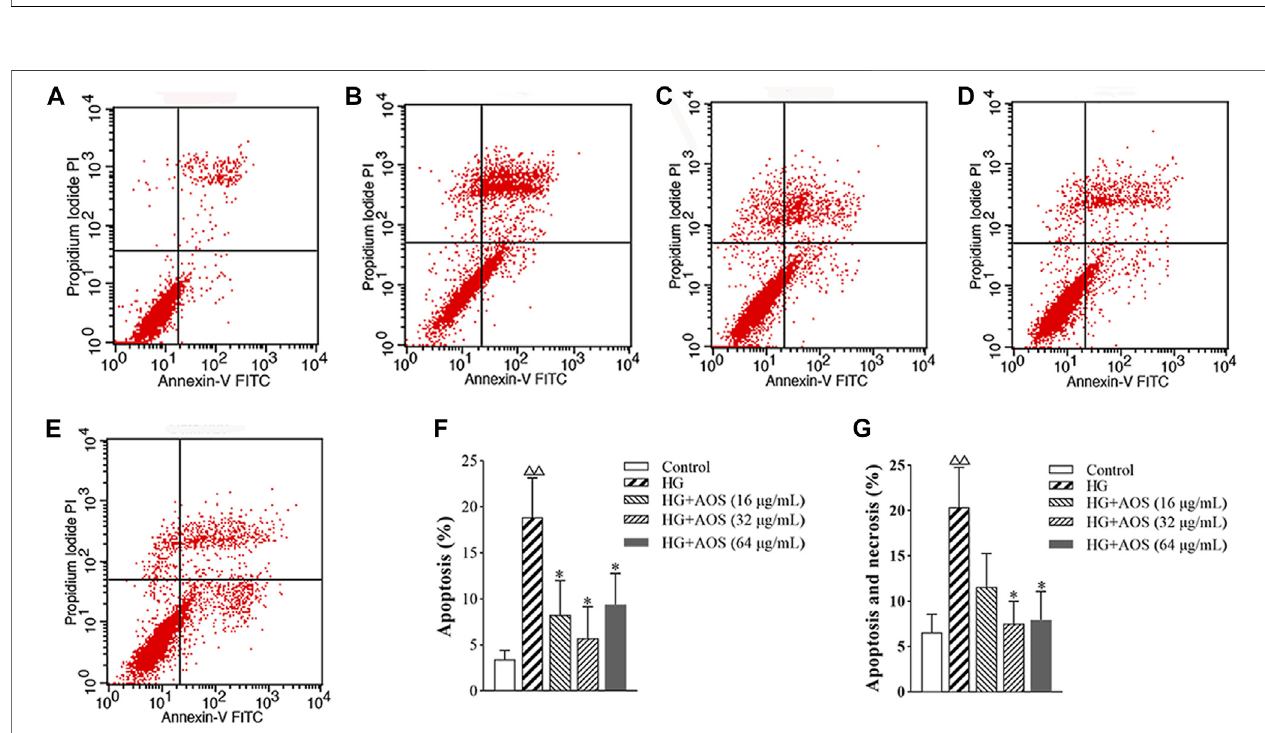
FIGURE 6 | AOS inhibits high glucose-induced MIN6 cell apoptosis. MIN6 cells were preincubated with glucose (33.3 mmol/L) for 24 h and then exposed to AOS (16, 32, and 64 μ g/ml) for 24 h. The rate of apoptosis was determined by fl ow cytometry. (A) Control. (B) High glucose. (C) High glucose + AOS (16 μ g/ml). (D) High glucose + AOS (32 μ g/ml). (E) High glucose + AOS (64 μ g/ml). ( F) Quanti fi cation of apoptotic cells. (G) Quanti fi cation of apoptotic and necrosis cells. Values are expressed as the mean ± SD (n (cid:1) 3). △△ p < 0.01 vs. Control; p p < 0.05 compared with high glucose.